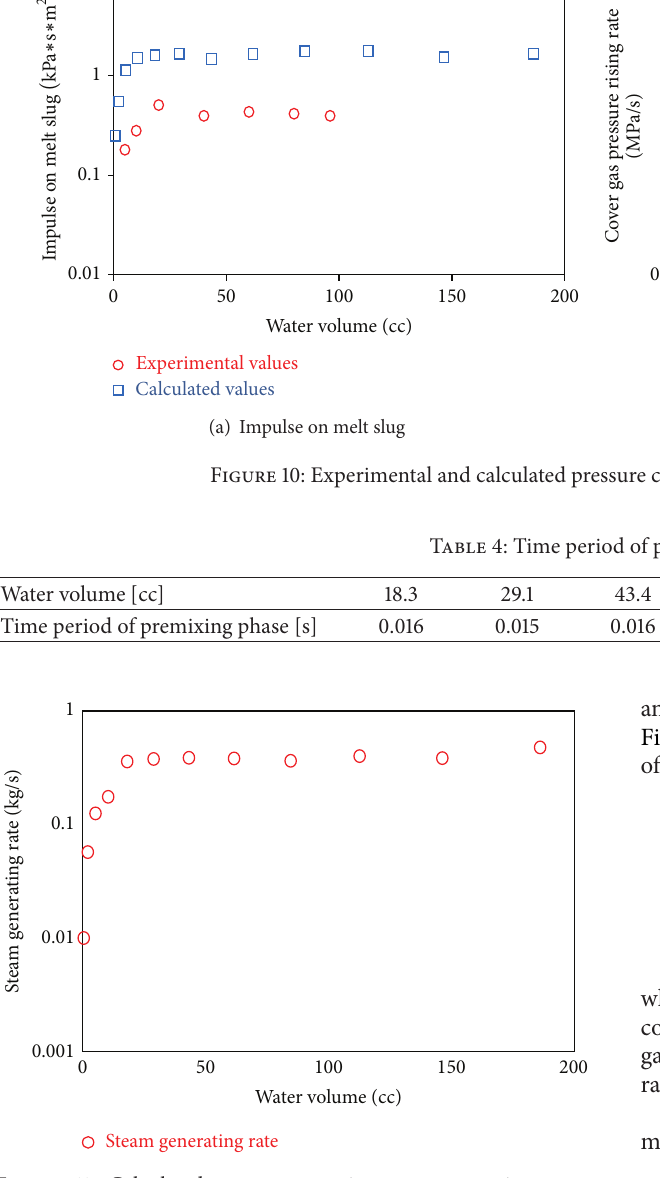
Figure 11: Calculated steam generating rate at varying water